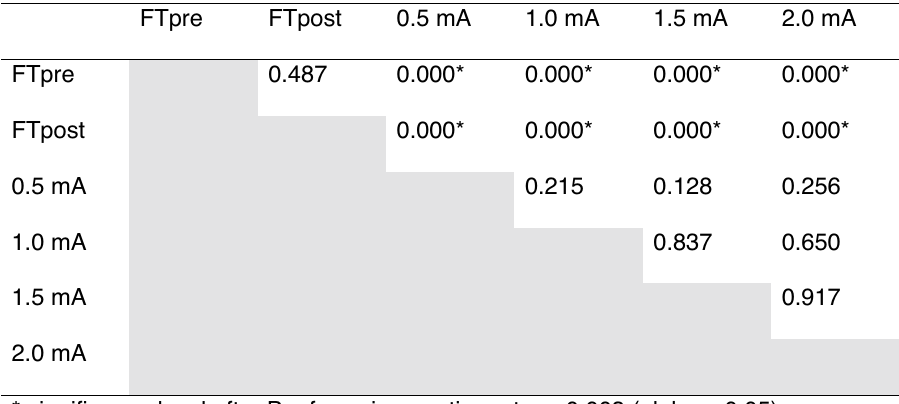
Table 1. Pairwise comparisons between fingertapping and TDCS activation (M1